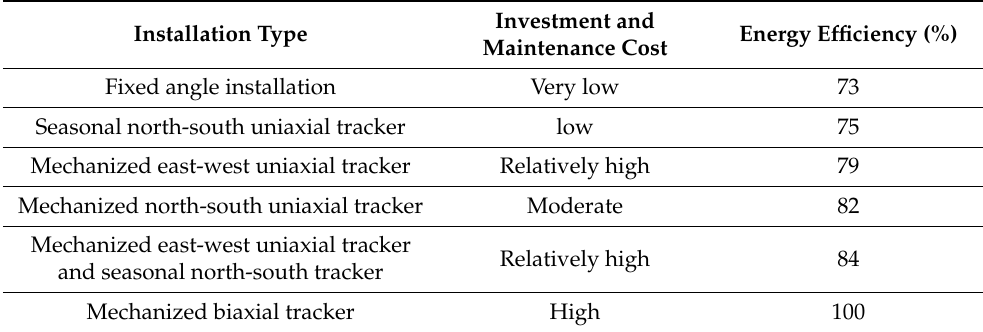
Table 1. A comparison of the economic performance of different types of tracking systems [35]. Investment and Energy Efficiency (%) Installation Type Maintenance Cost Fixed angle installation Very low 73 Seasonal north-south uniaxial tracker low 75 Mechanized east-west uniaxial tracker Relatively high 79 Mechanized north-south uniaxial tracker Moderate 82 Mechanized east-west uniaxial tracker Relatively high 84 and seasonal north-south tracker Mechanized biaxial tracker High